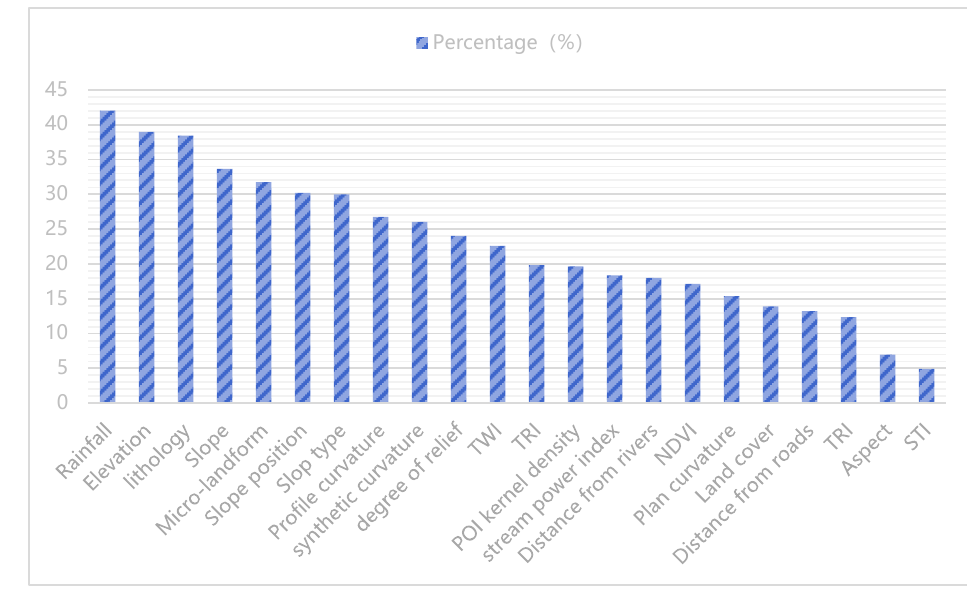
Figure 8. Ranking the importance of factors influencing landslide susceptibility.